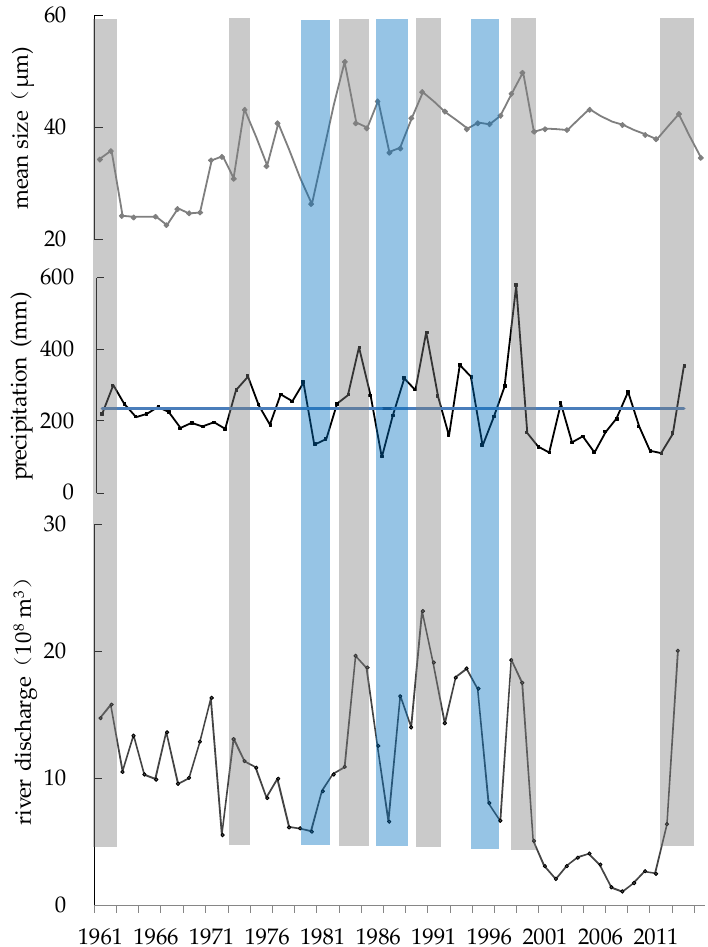
Figure 7. Comparisons the mean grain size in the lake sediment with the precipitation and river discharge records (gray boxes indicate the peaks of precipitation correspond to peaks of the mean grain size, blue boxes indicate the troughs in the precipitation correspond to the troughs of the mean grain size, blue horizontal line is the annual average precipitation).